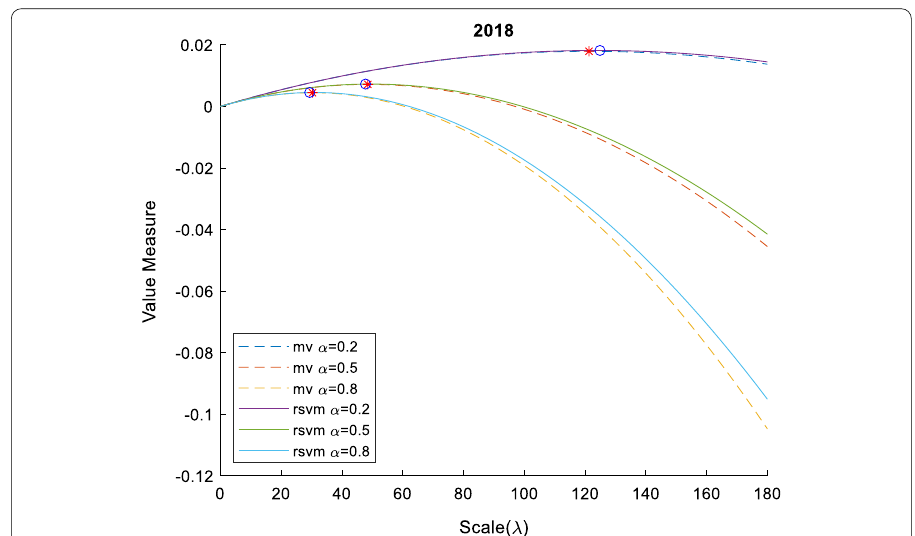
Fig. 5 Value measure of RSVM and MV with various risk aversion α and scale (cid:31) in 2018. This figure shows the relation between value measure (mean–variance model with dash line and risk‑sensitive value measure with line) and scale with different investors (risk‑averter α = 0.8 , risk‑neutral α = 0.5 , and risk‑seeker α = 0.2 ) in 2018. The red star and blue circle are optimal scale of mean–variance model and risk‑sensitive value measure, respectively